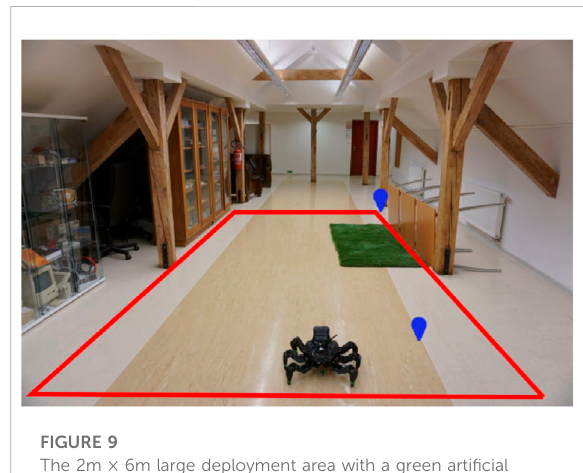
FIGURE 9 The 2m × 6m large deployment area with a green arti fi cial turf. The area boundary is in red,and thewaypoints ofthe test tour are depicted in blue. The shown robot is at the starting